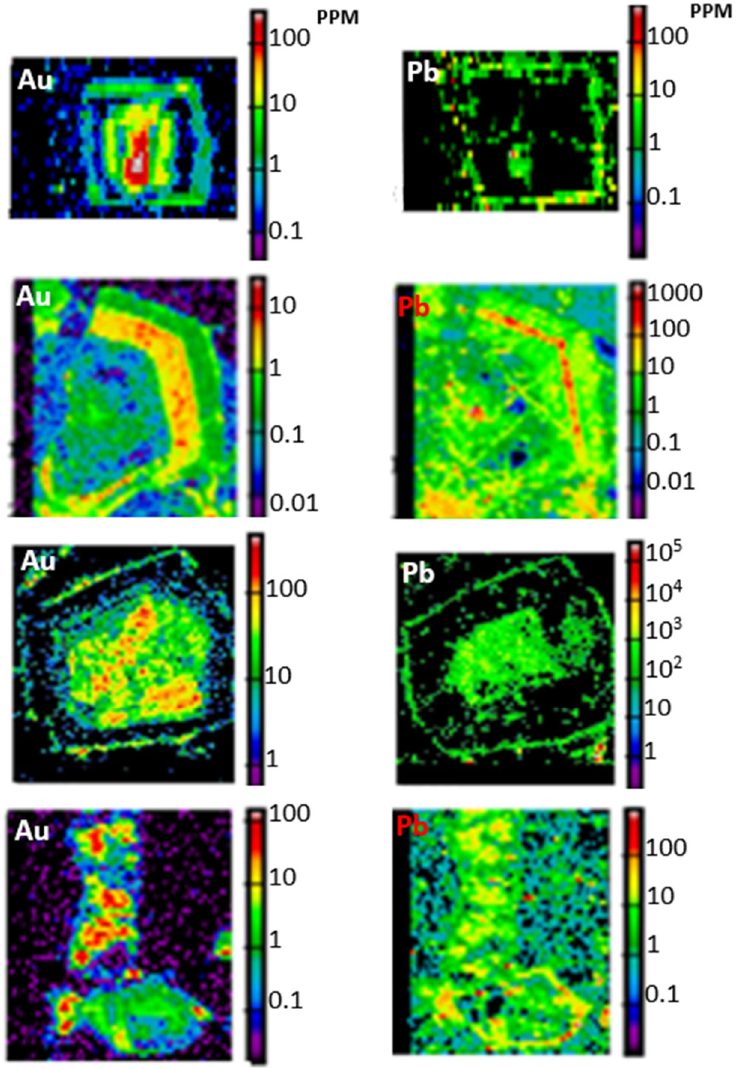
Figure 14. Gold and lead occurrences in pyrite crystals found in black shales from the Tersang and Selinsing gold deposits in Malaysia showing consistent synchronous patterns in the pyrite lattices.